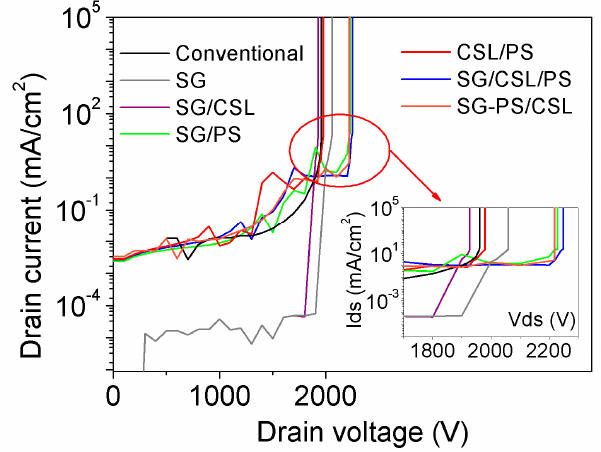
Figure 3. The reverse blocking characteristics between different gate designs. The breakdown voltages of the proposed SG–PS/CSL and SG/CSL/PS structure is 2250 V. © (2020) IEEE. Reproduced, with permission, from [14].